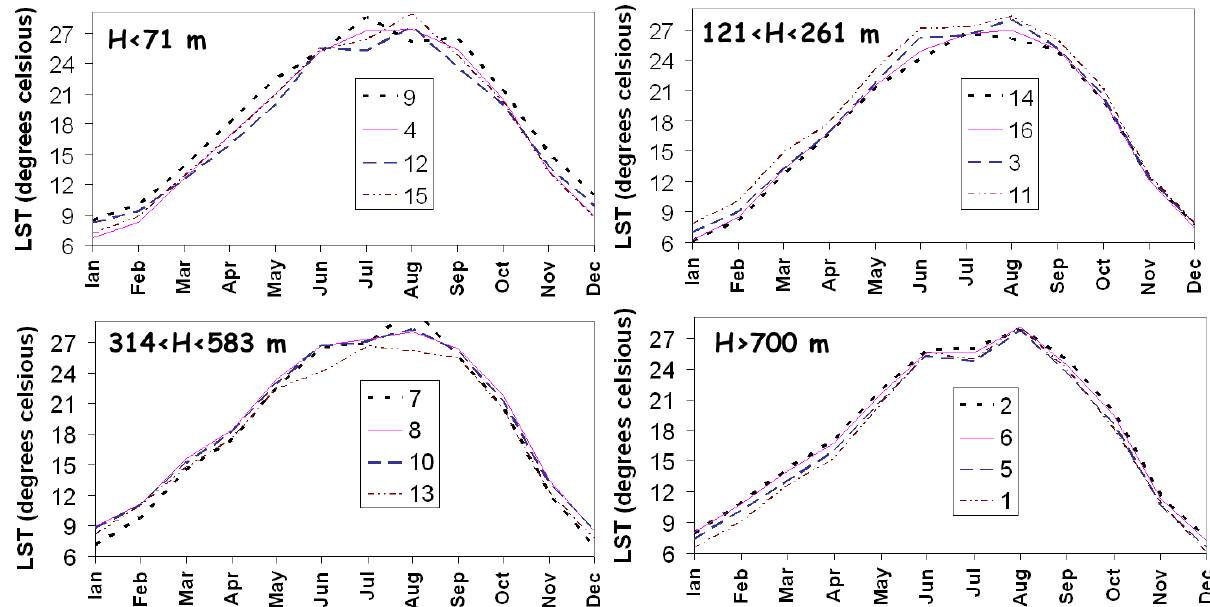
Figure 8. The LST centroids of the 16 clusters (Table 2) organized into four categories in increasing mean elevation (H) (Figure 10). The mean elevation (H) range per category is indicated in each